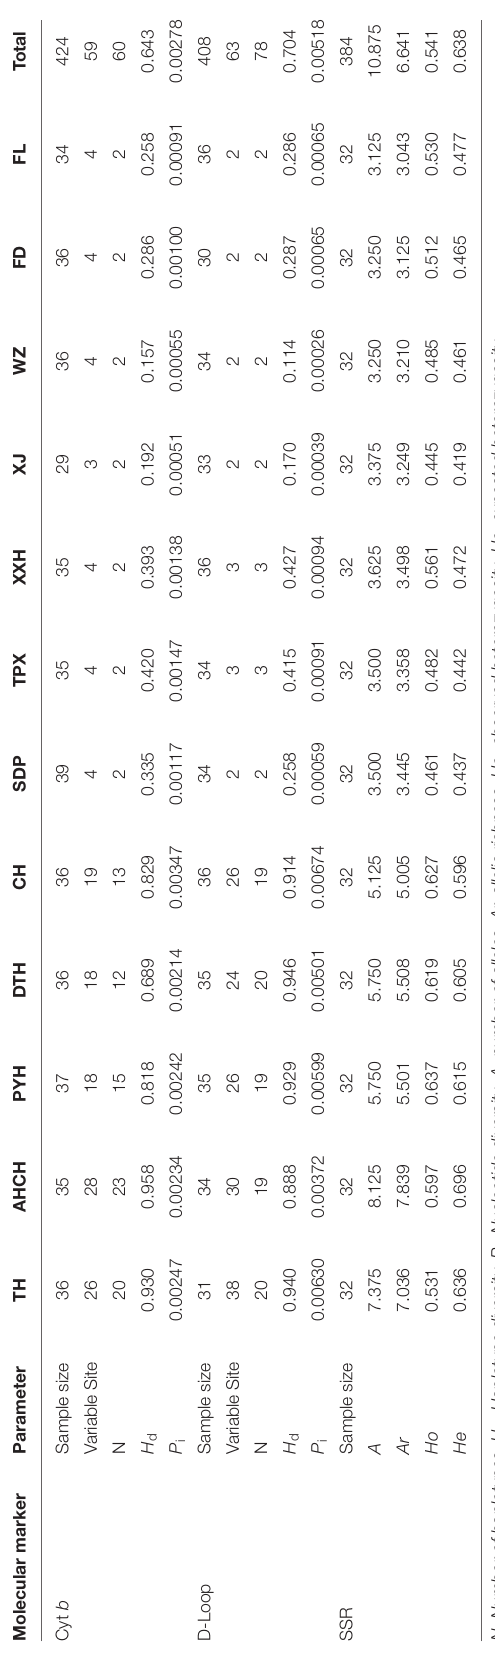
A total of 384 samples from 12 localities and 8 polymorphic SSR loci were used in the present study. No evidence for scoring errors due to stuttering, large allele dropout, or null alleles was detected by Micro-Checker. Ten of 96 population × locus combinations were significantly different from the HWE after Bonferroni correction, whereas no significant deviation from the HWE was detected in any locus across all populations. No loci pairs showed evidence of LD after Bonferroni correction. When data from all populations were pooled, the number of alleles at each locus ranged from 6 to 25, so all the eight loci were polymorphic ( Supplementary Table 2 ).